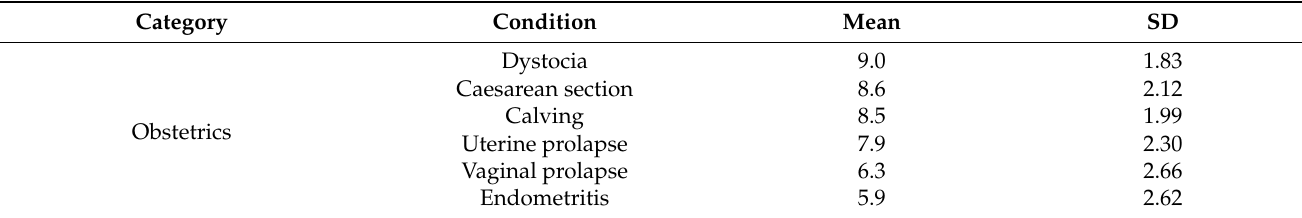
Table 2. Pain score (range 0–10) of the 26 painful conditions in adult dairy cattle and calves scored by 465 dairy